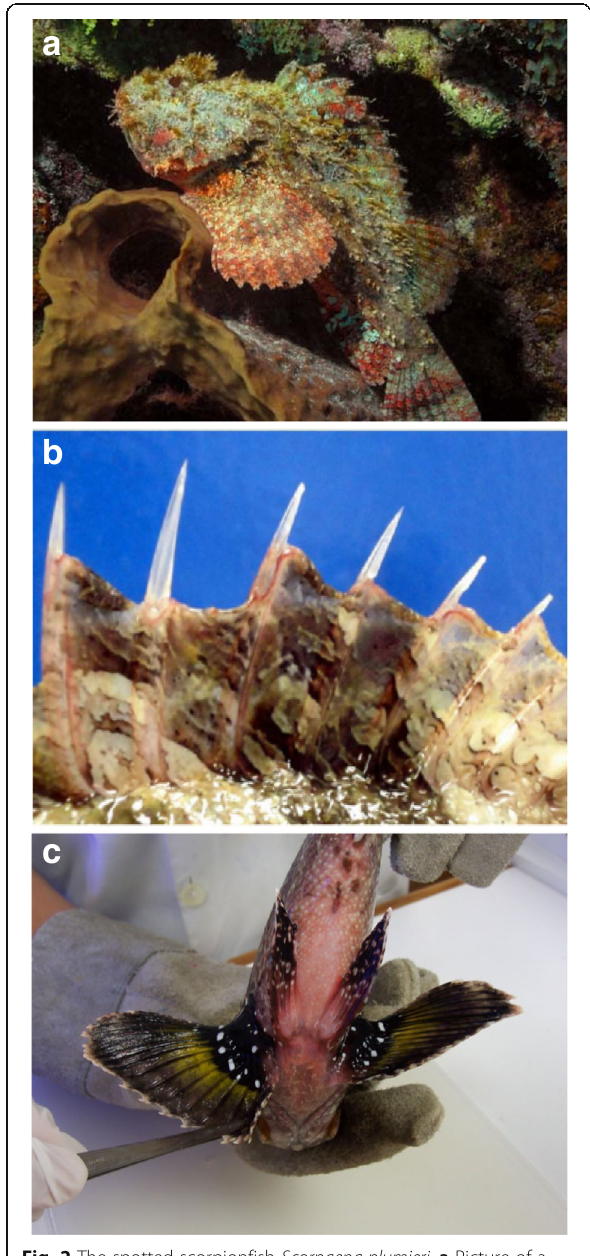
Fig. 2 The spotted scorpionfish Scorpaena plumieri . a Picture of a specimen of S. plumieri highlighting its camouflage capability. b Erected dorsal spines covered in mucous skin form — along with the pelvic and anal fin spines — the venom apparatus of S. plumieri . c White spots against a black background on the inner part of the pectoral fins, a characteristic feature of this